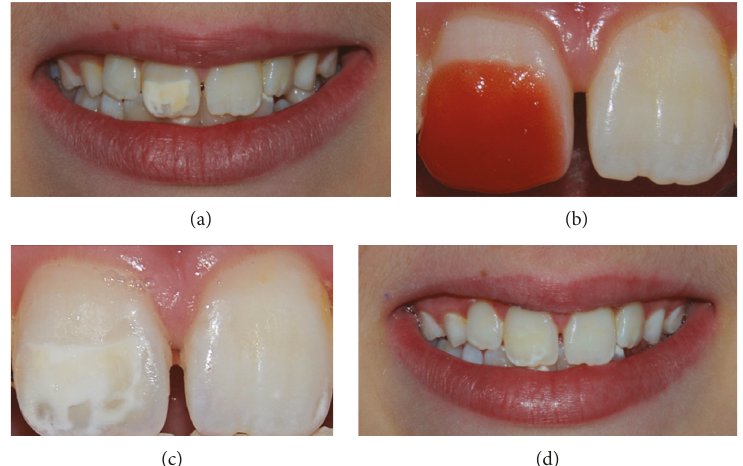
Figure 2: Yellowish lesion related to molar incisor hypomineralization (a). The combination of in-o ffi ce bleaching (38% H a single visit for 15min (c) and resin in fi ltration procedure were su ffi cient to end up with an esthetically satisfying result. By the end of the in fi ltration step, the incisal part of the lesion was not completely in fi ltrated probably due to excessive depth of the lesion at this area (d).